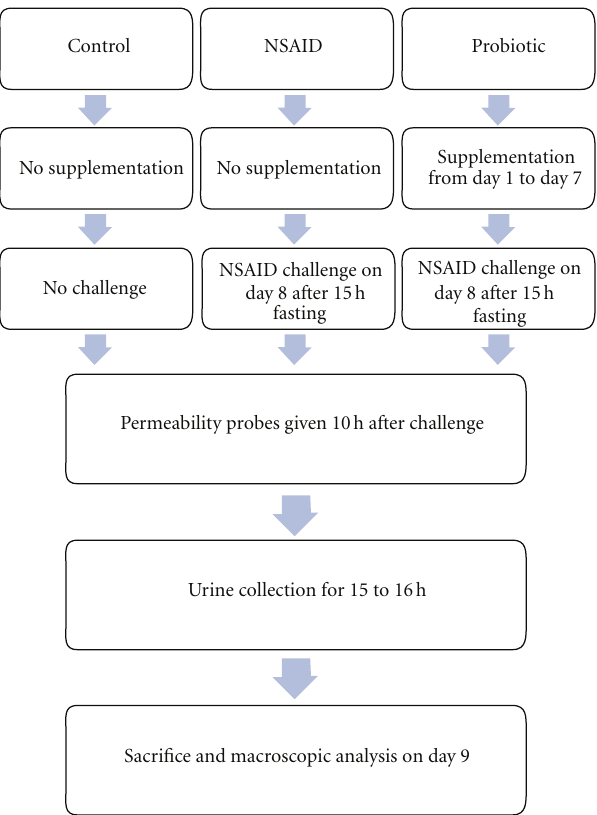
Figure 1: Study protocol outline followed in animal studies. The probiotic group rats were given live Bifidobacterium lactis B420 cells (high dose or low dose), a cell-free extract or pure lactic acid as